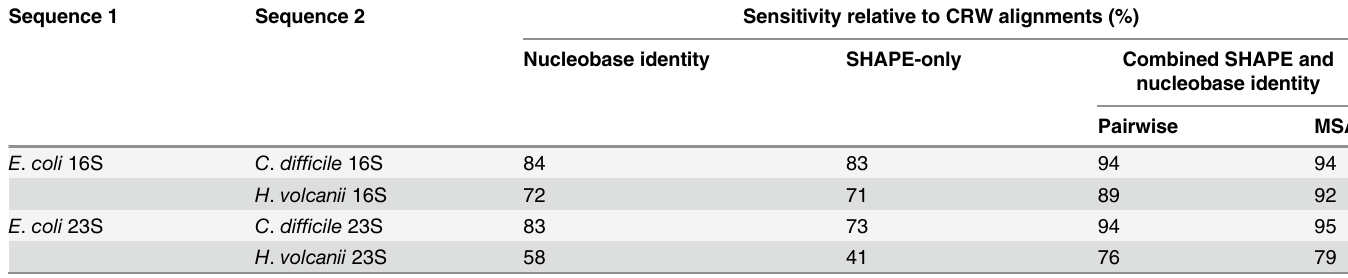
sequence alignments (Table 1). For example, for 16S rRNA, SHAPE-based alignments had sen- sitivities of 83% and 71% for alignments of E . coli to C . difficile and to H . volcanii , respectively; whereas, conventional sequence identity-based alignments using the Needle algorithm had sensitivities of 84% and 72%, respectively. For 23S rRNA, SHAPE-based alignments performed well but not quite at the level of sequence-based alignment (Table 1). Table 1. Sensitivities of pairwise SHAPE-dependent sequence alignments relative to accepted